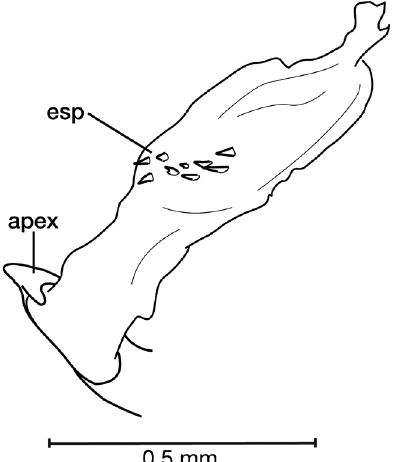
Figure 63. Line drawing of the phallus apex and endophallus, right lateral aspect, of Dolichoctis badia- dorsis sp. n.. Legend: esp endophallic spine patch; apex distinctively hooked phallus